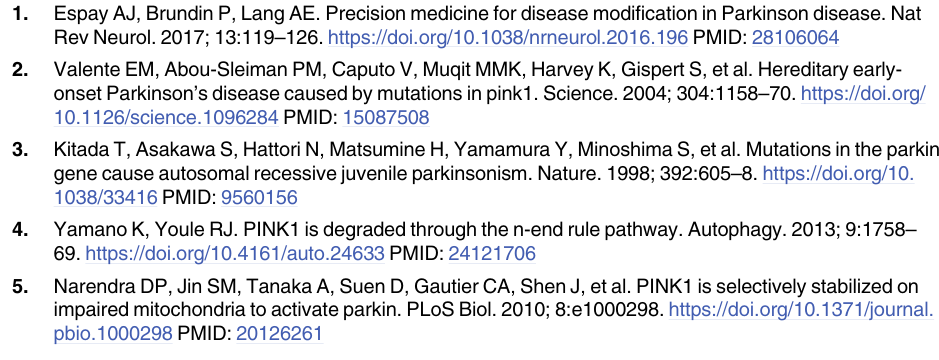
S2 Table. Characteristics of primary antibodies used in this